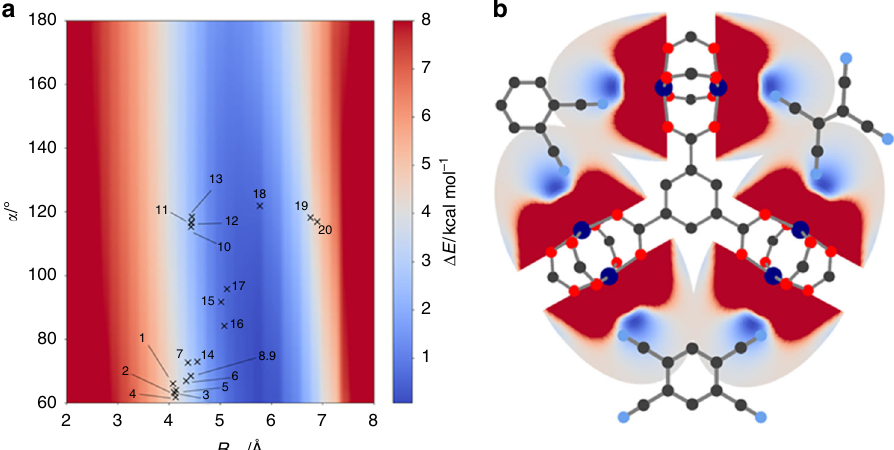
Fig. 4 RetroFit results for Cu 3 BTC 2 . a RetroFit map for Cu 3 BTC 2 and the tested dinitrile-CLs. The energy penalty Δ E for the CL parameters R NN and α is given as color code and increases from blue to red. Values of Δ E , which exceed the color scale bar are set to 8 kcal mol − 1 for better visualization. The smallest Δ E and in turn the best fi t is obtained for CLs with 3 and 4-membered rings ( 15 , 16 , 17 and 18 ). A table overviewing the results is given in Supplementary Note 7 (Supplementary Table 3). b Visualization of the fi t of the CLs 5 , 12 , and 20 with ortho, geminal and meta con fi guration, respectively. Cu, C, N, and O atoms are shown in dark blue, black, blue and red. The potential around the OMSs is illustrated as Δ E increasing from blue to